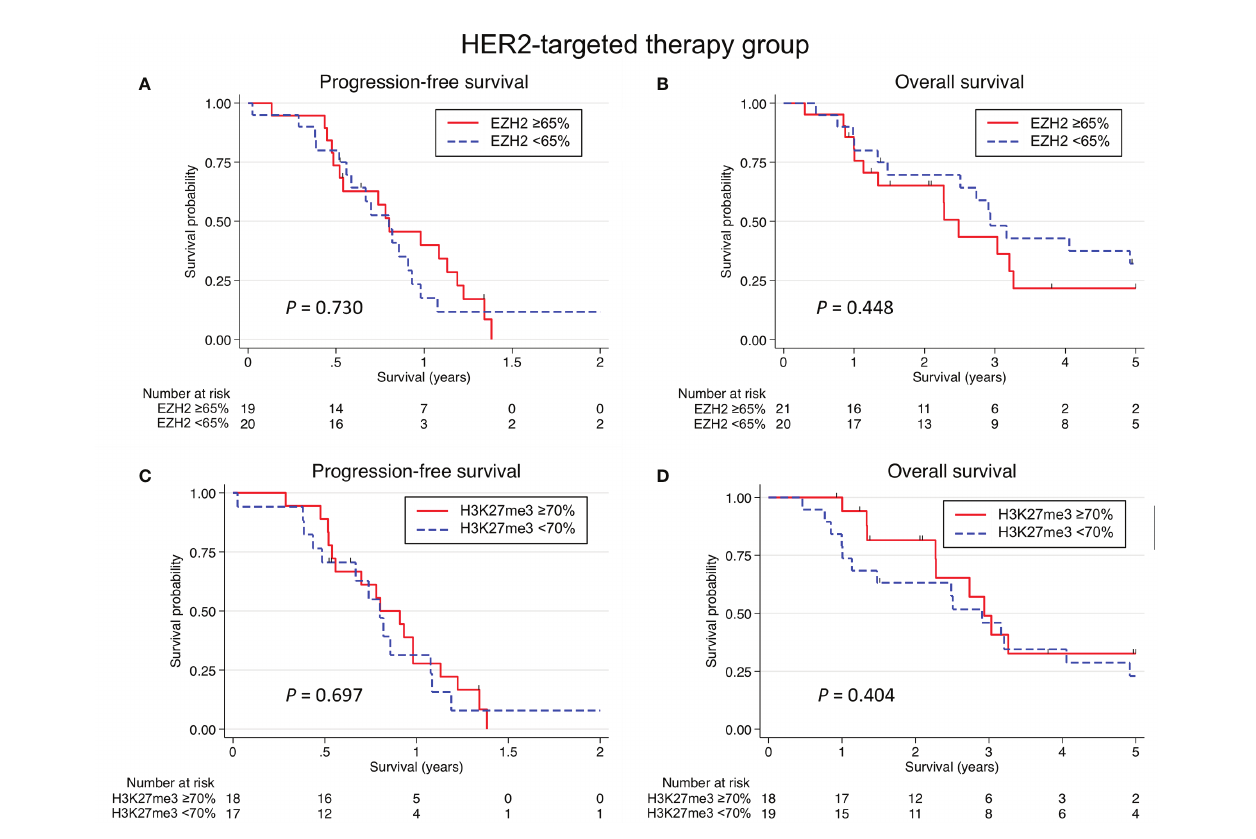
FIGURE 6 | Kaplan-Meier survival curves according to the EZH2/H3K27me3 expression in salivary duct carcinoma treated with HER2-targeted therapy. No signi fi cant association was identi fi ed between the EZH2 expression and the progression-free survival (PFS) (A) or overall survival (OS) (B) . There was also no signi fi cant association between the H3K27me3 expression and the PFS (C) or OS (D)